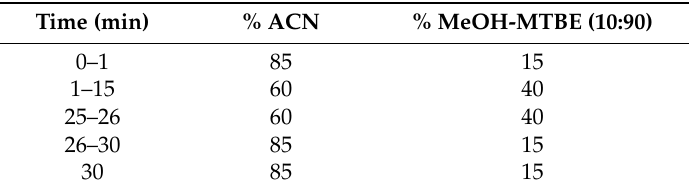
Table 5. HPLC gradient used for the analysis of TRIA.